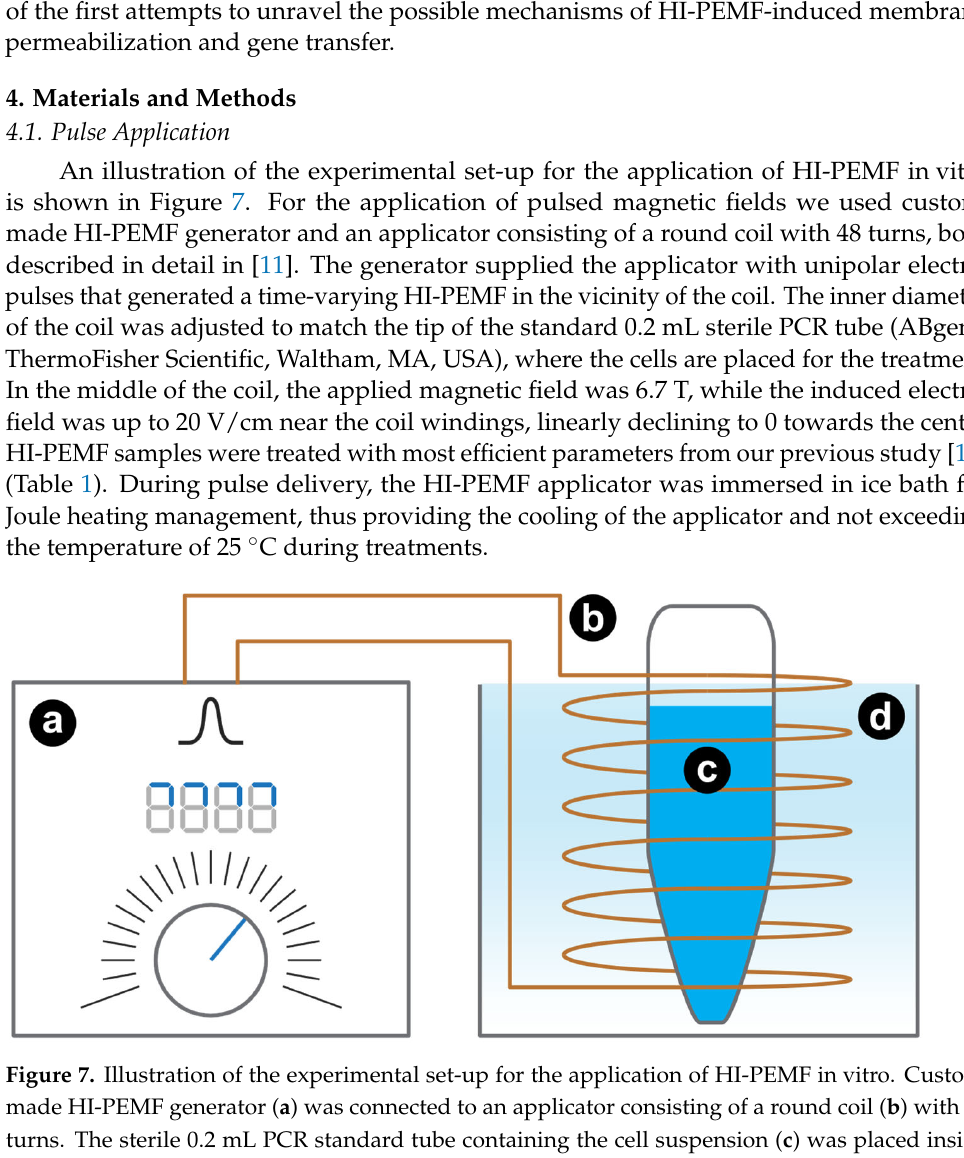
evaluation of gene electrotransfer to a single conventional electroporation protocol— µ